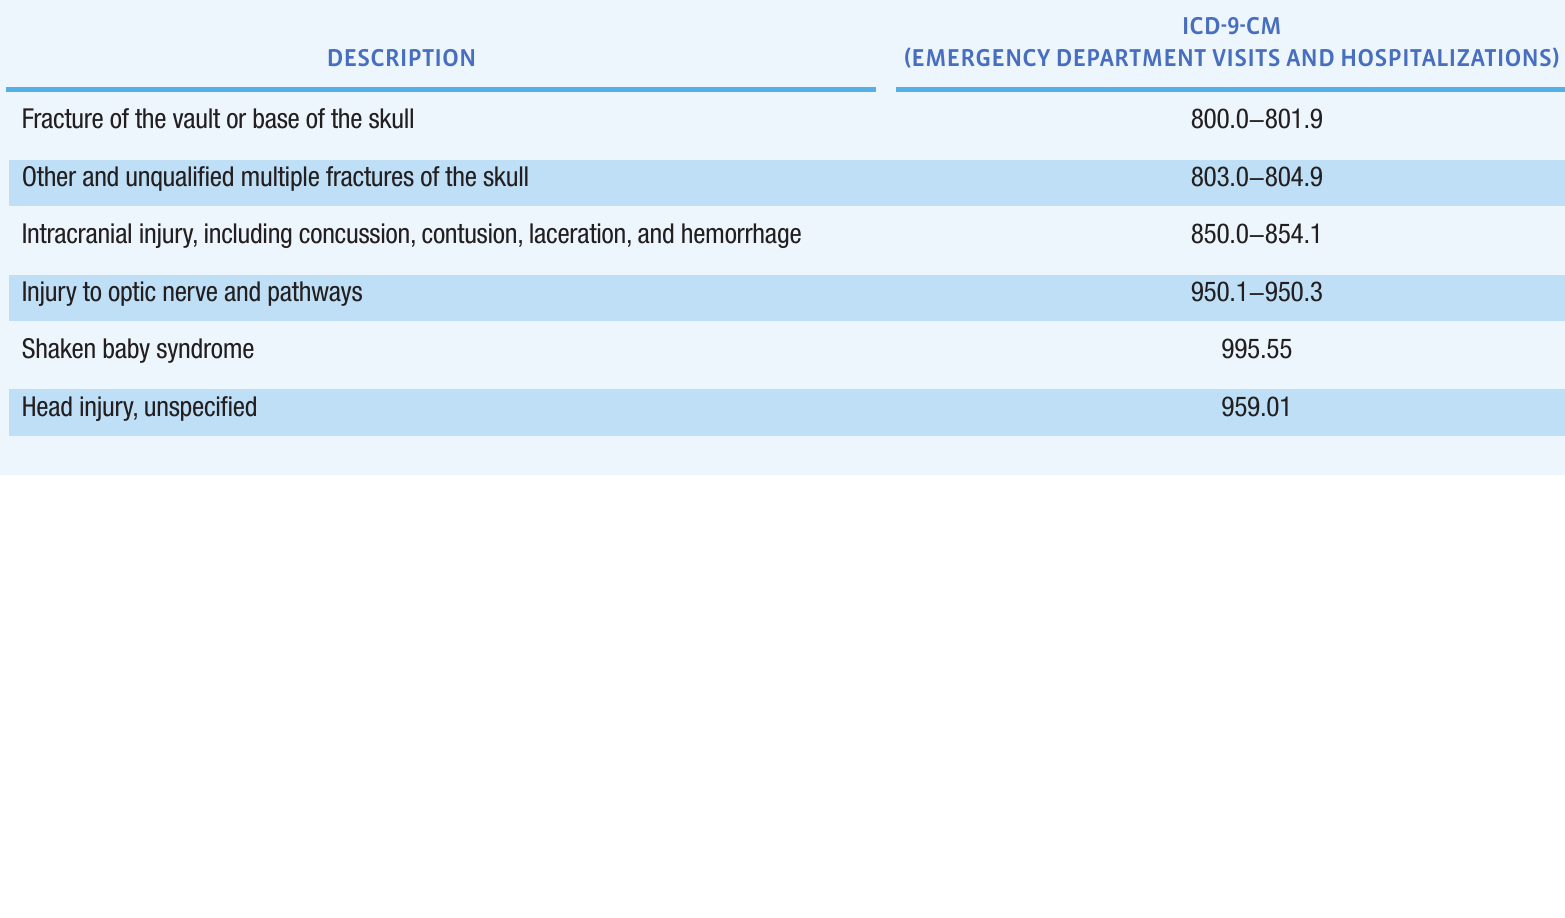
TABLE 18: ICD-9-CM Codes for Traumatic Brain Injury-Related Emergency Department Visits and Hospitalizations